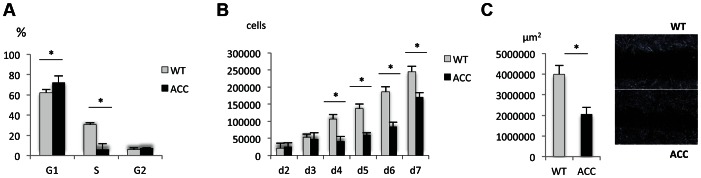
ACC fibroblasts with mutated BMS1 show a G1/S phase cell cycle transition delay and reduced cell proliferation rate.a. Primary ACC fibroblasts show a significantly reduced proportion of cells in S-phase compared to control fibroblasts (WT), consistent with a delay in G1/S phase transition in mutant cells. PI staining and FACS-based analysis. * P-value<0.05 for cells in G1 and S phase. b. Cell proliferation rate is reduced in ACC fibroblasts. * P-value<0.05 for values between d4 to d7. c. In vitro scratch assay of fibroblasts on fibronectin-coated dishes show increased cell migration rate in ACC fibroblasts (assayed at 14 hours after scratch). Images taken with a 2.5× objective. * P-value<0.05. Graph shows area not repopulated with fibroblasts.